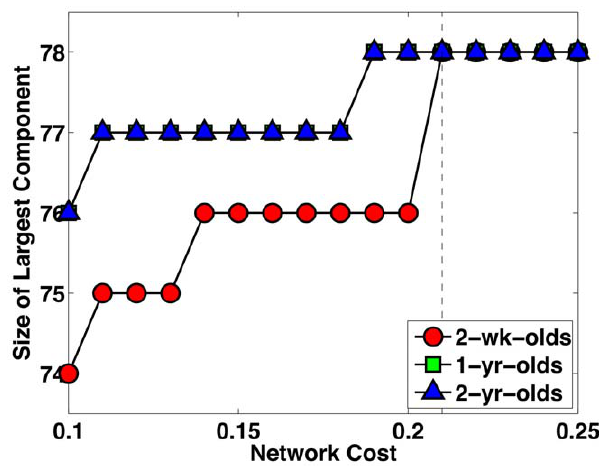
Figure 3. Largest Connected Component. The number of nodes of the largest connected component in all networks stabilize and reach the maximum possible value (78) at the network cost of 0.21, a value which we used for our analysis, unless otherwise stated.